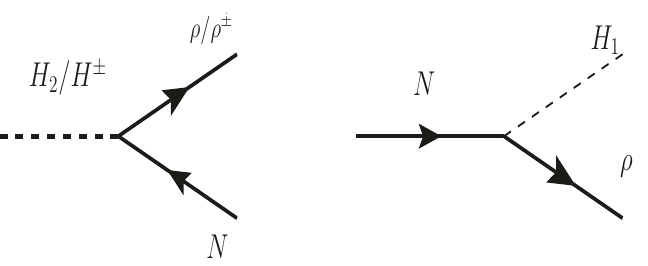
Figure 6 . Feynmann Diagram for the dominant production of N as well as its late decay to DM ρ .